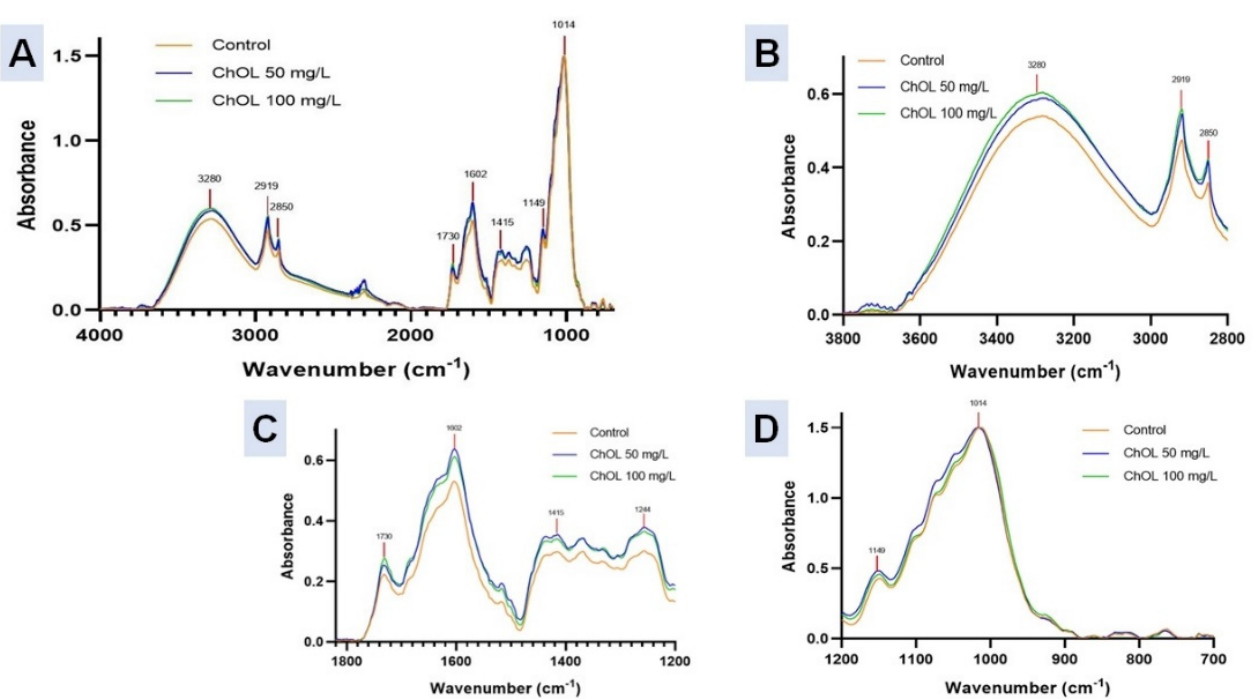
Figure 5. Fourier transform infra-red spectroscopy (FT-IR) spectra of red perilla treated with chitosan oligosaccharide lactate (ChOL) ( A ) whole FT-IR spectrum (4000–700 cm − 1 ); ( B ) in the range of 3600–2400 cm − 1 (–OH, –NH, –CH 2 and –CH 3 groups); ( C ) in the range of 1800–1200 cm − 1 (proteins); ( D ) in the range of 1250–700 cm − 1 (polysaccharides).